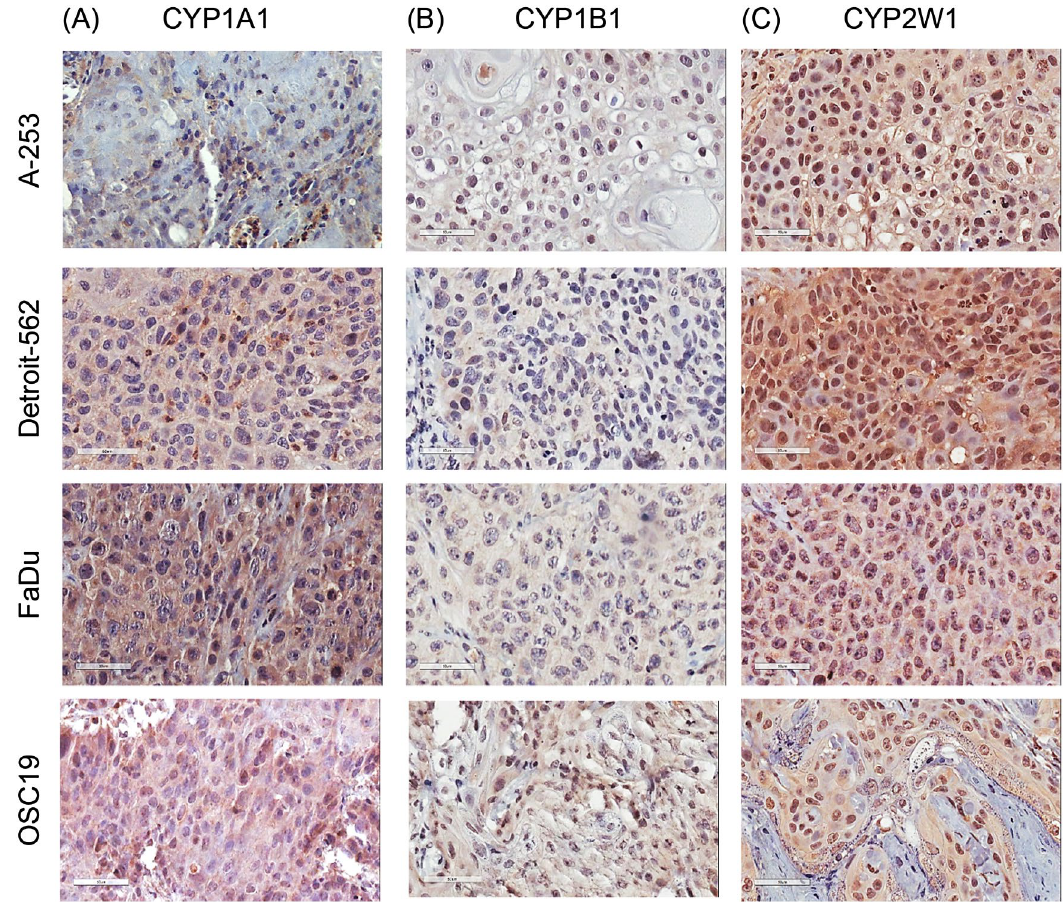
Figure 3. Immunohistochemical staining of CYP1A1 ( A ), CYP1B1 ( B ) and CYP2W1 ( C ) in tumour xenografts. Scale bar = 50 μm at 40 × magnification.